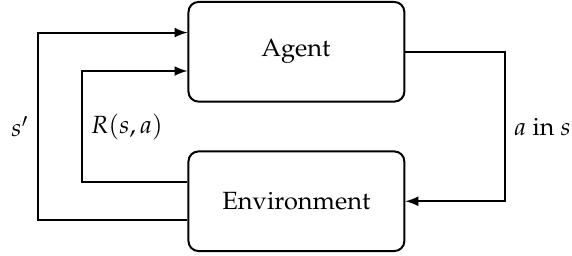
Figure 2. Illustration of Reinforcement